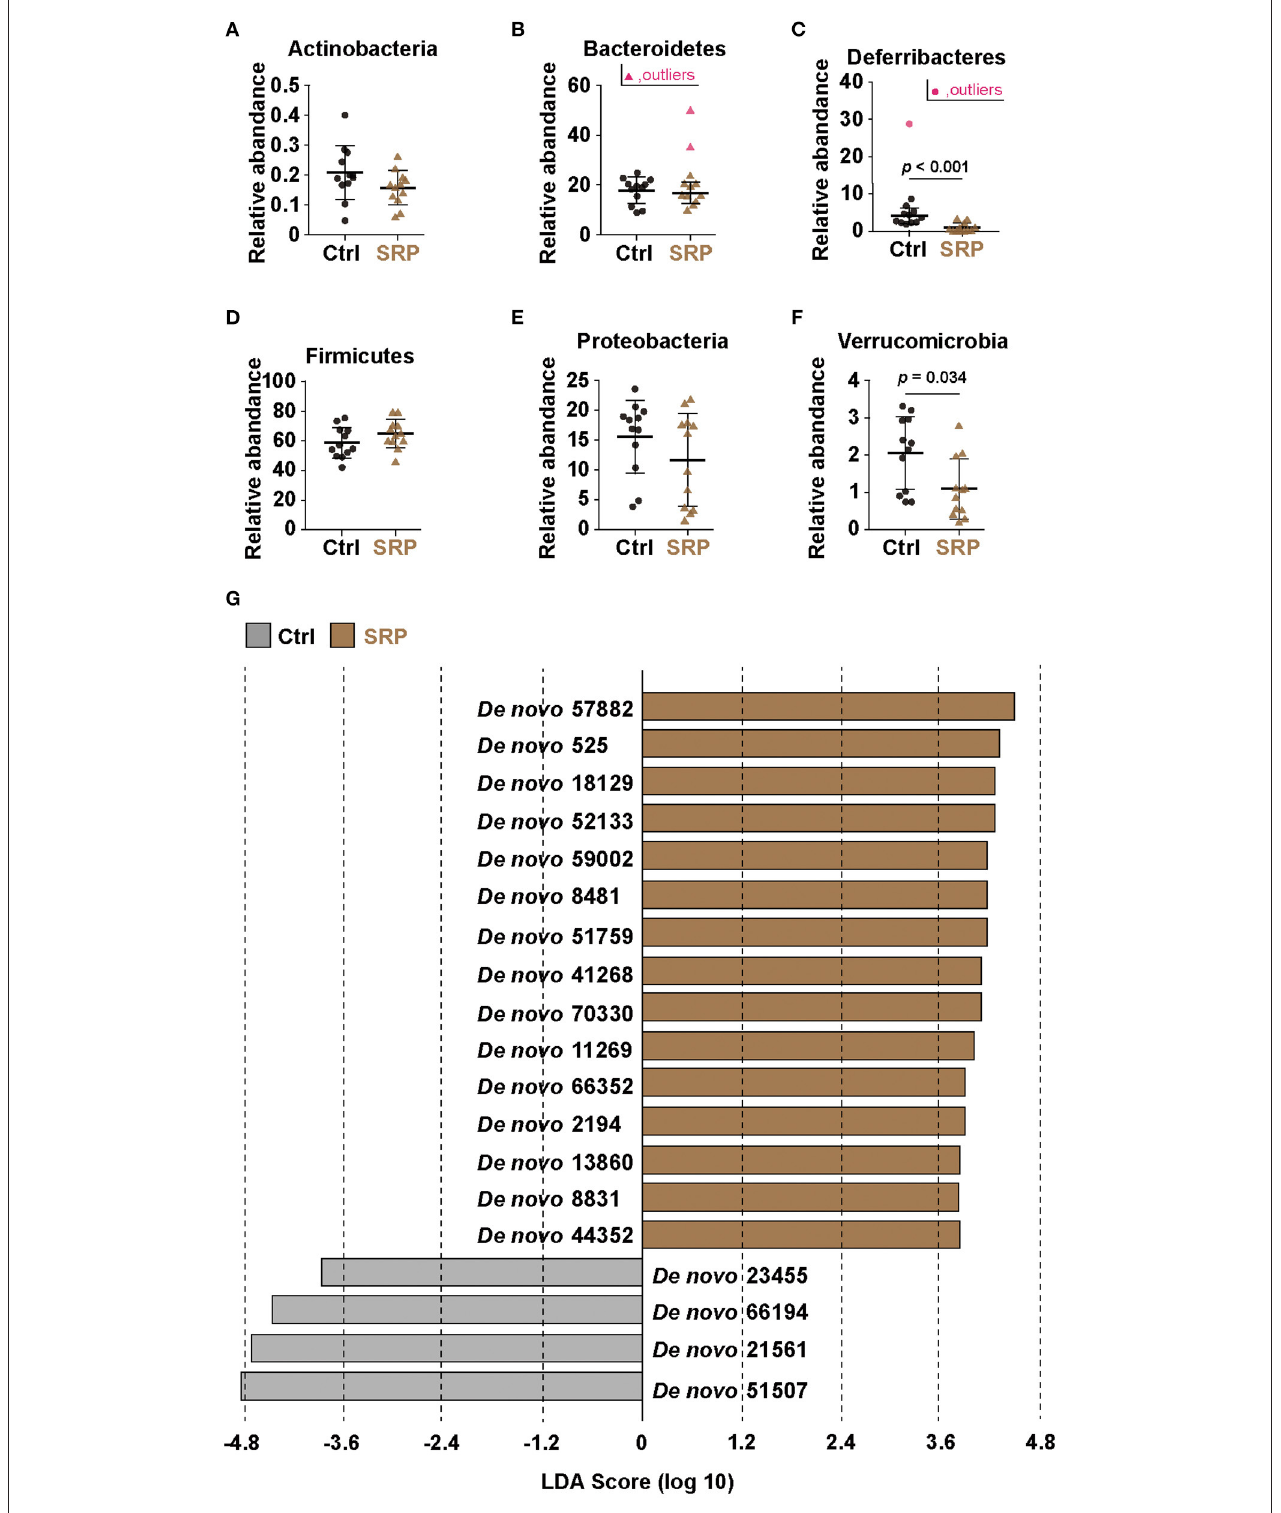
FIGURE 3 | Effects of the SRP-diet on the cecal microbiota. Proportions of the total content of Actinobacteria (A) , Bacteroidetes (B) , Deferribacteres (C) , Firmicutes (D) , Proteobacteria (E) , and Verrucomicrobia (F) were assessed in the cecal contents by MiSeq [ n = 10–12; values are expressed as the mean (SD)]. p indicates the p -value. Selection of the cecal microbiota was based on linear discriminant analysis (LDA) (G) . Operational taxonomic units (OTUs) were determined to be significantly different according to the LDA score (LDA > 3). OTUs showing significant differences ( p < 0.05) between the two groups were extracted by the Kruskal-Wallis and Wilcoxon rank-sum tests. Ctrl, control diet group; SRP, soybean resistant protein diet group.